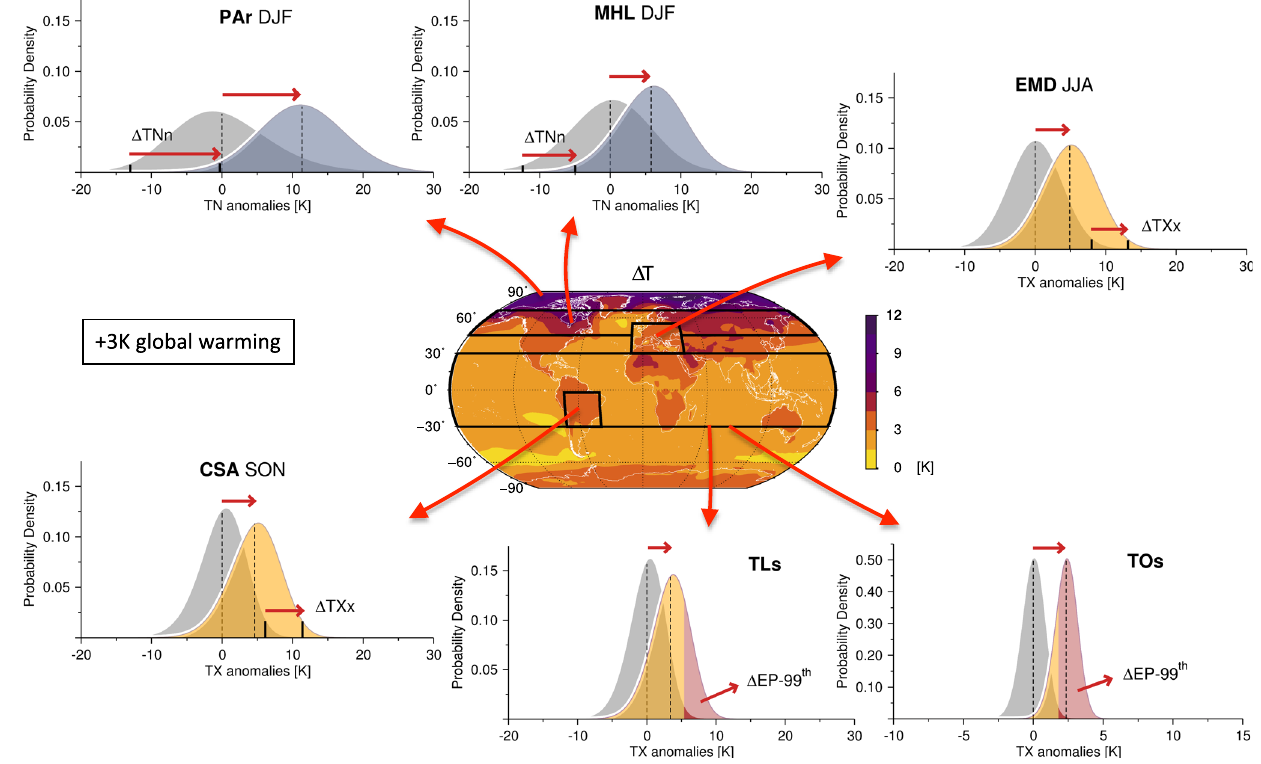
Fig.9|Summarychartofmajorhotspotchanges. Schematicillustrationoffuture changes in the magnitude and frequency of heat extremes over the hotspot zones at +3K warming (Supplementary Table 2), and their relations with changes in the underlying thermaldistributions.A theoretical density function allowing skewness